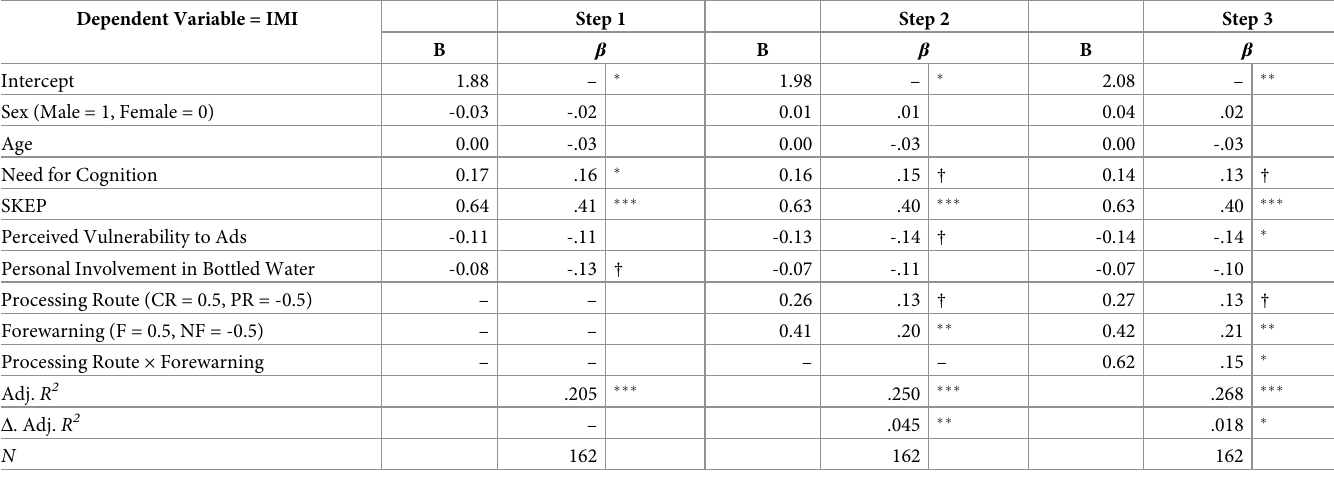
Table 2. Results of a hierarchical regression on